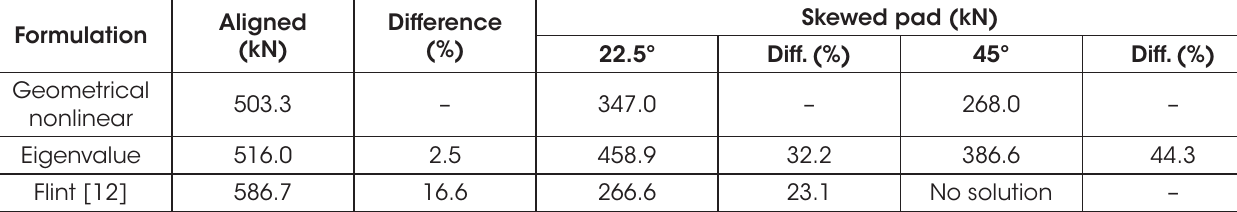
Comparison between numerical and analytical